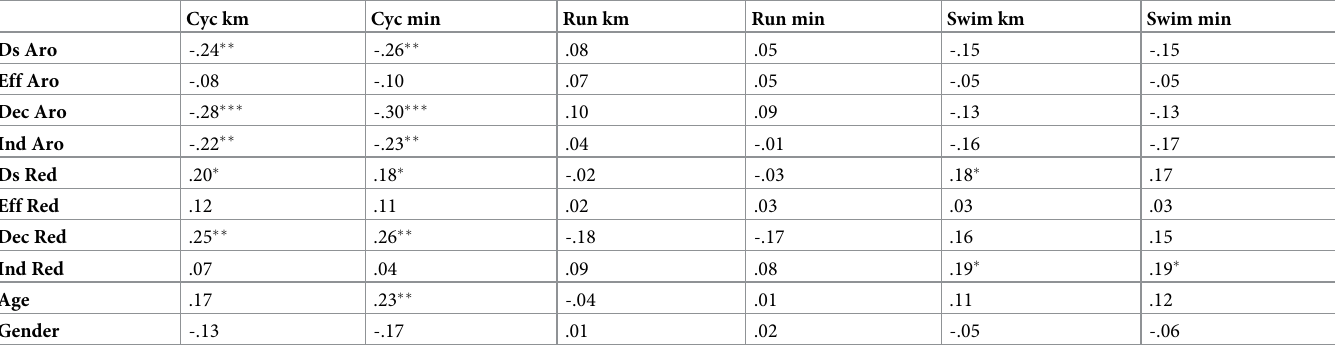
Table 1. Correlations of dissonance-related variables with exercise variables (Study